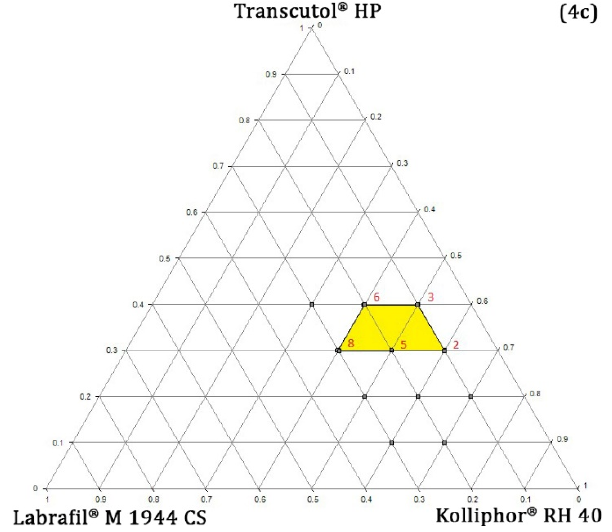
Figure 4. The ternary phase diagram indicates a suitable region for the oil, surfactant, and co-surfactant concentration.